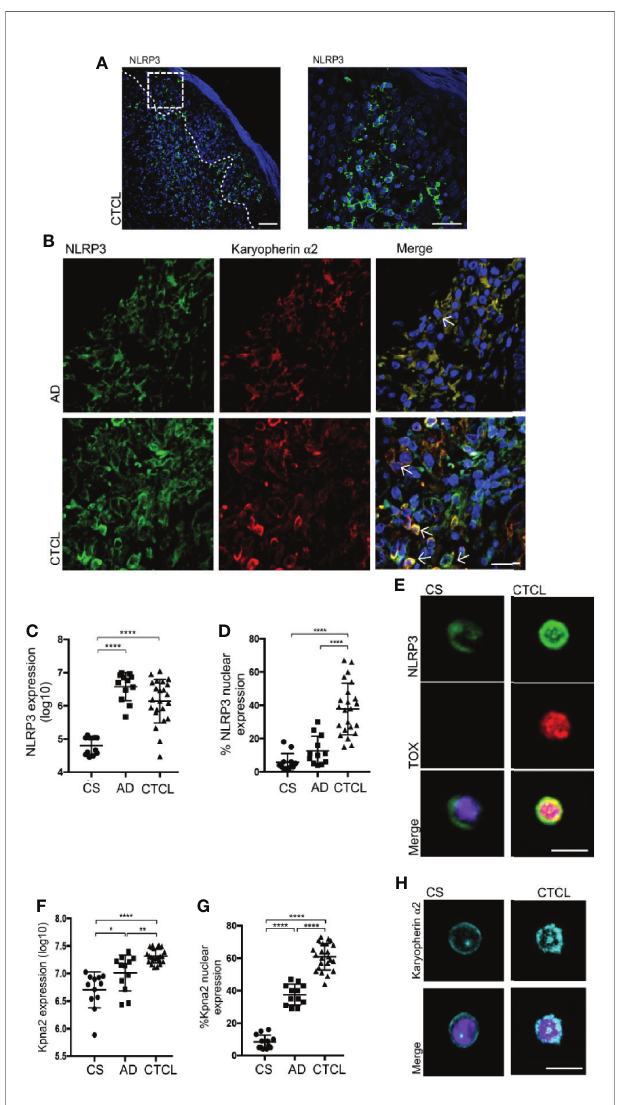
FIGURE 2 | NLRP3andkaryopherin a 2displaynuclearandperinuclearlocalization inCTCLplaques. (A) RepresentativemicrophotographshowingNLRP3expression inthePautriermicroabscessesarea. (B) Representativeimmuno fl uorescence(IF)and z-stackreconstructionsofNLRP3(AF-488)andkaryopherin a 2(AF-594)expression inCTCLplaquesandAD( SupplementaryVideos1 and 2 ,respectively). Quanti fi cationofthetotalexpressionof (C) NLRP3and (D) percentageofcellswith NLRP3nuclearexpressioninthemicrophotographsofCTCLplaques(n=23),AD (n=12),andCS(n=12). (E) RepresentativeIFofNLRP3(AF-488)andTOX (AF-594)inCD4 + TcellsisolatedfromCTCLplaquesandCS(n=5).Quanti fi cation ofthe (F) totalexpressionofkaryopherin a 2and (G) percentageofkaryopherin a 2 + cellsinthemicrophotographsofCTCLplaques(n=23),AD(n=12),andCS (n = 12). (H) Representative IF of karyopherin a 2 in CD4 + T cells isolated from CTCL plaques and CS (n = 5). Arrows indicate coexpression of markers in the different staining. Error bars = SEM. *P < 0.05, **P < 0.01, ****P < 0.0001. Scale bars= 20